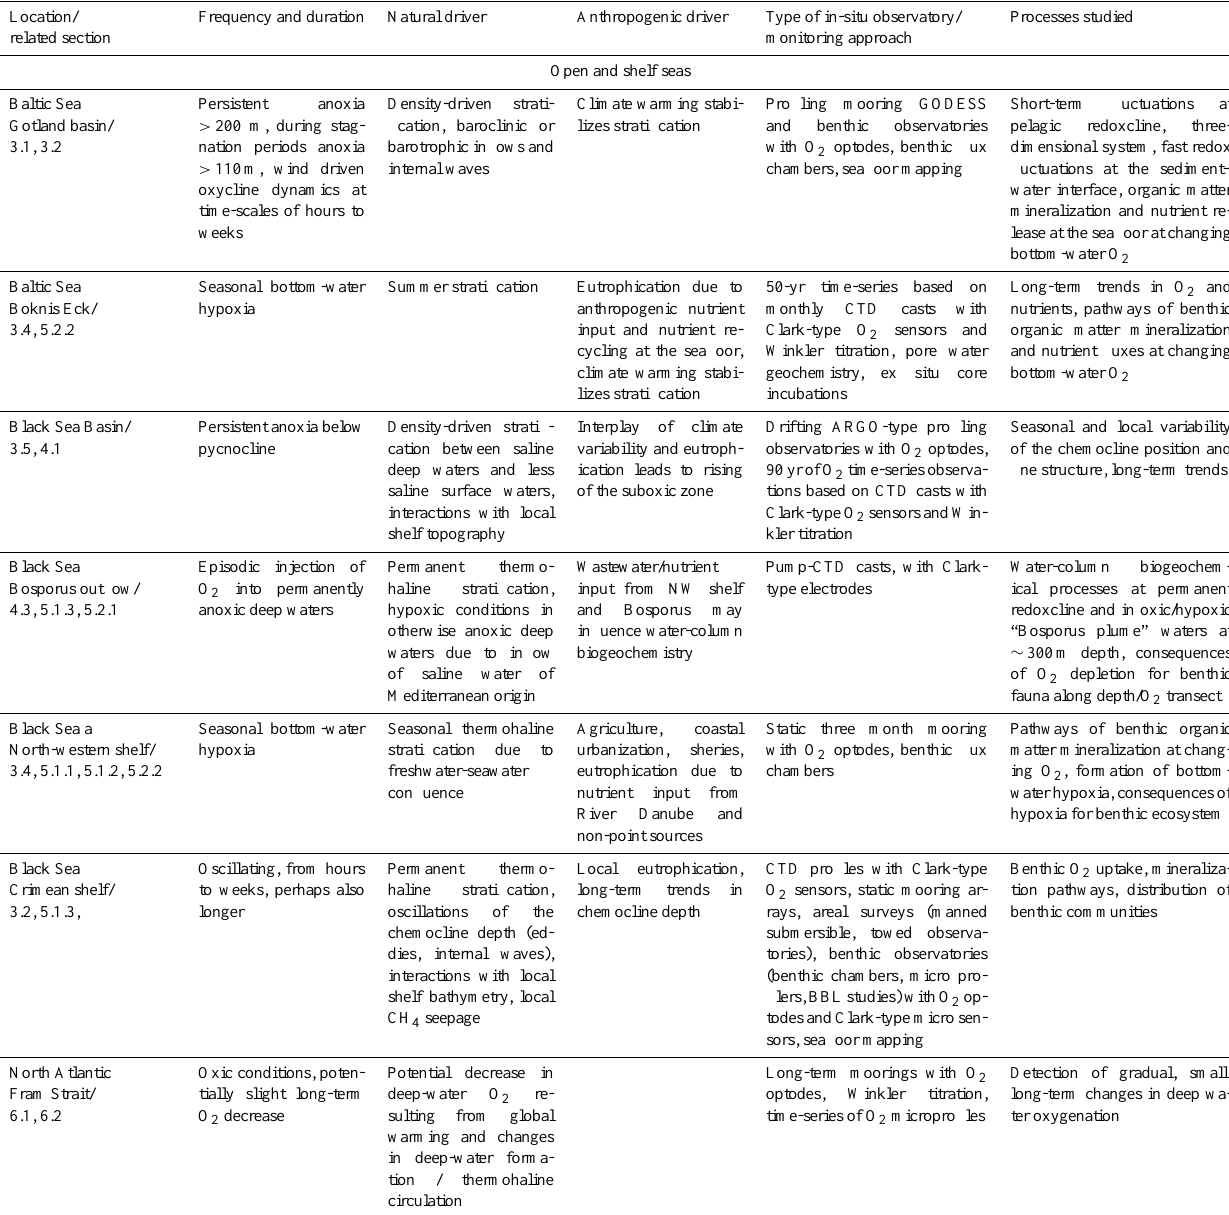
Table 1. HYPOX study sites, temporal occurrence and drivers of oxygen depletion, monitoring approaches, processes investigated, and references to the sections containing more detailed